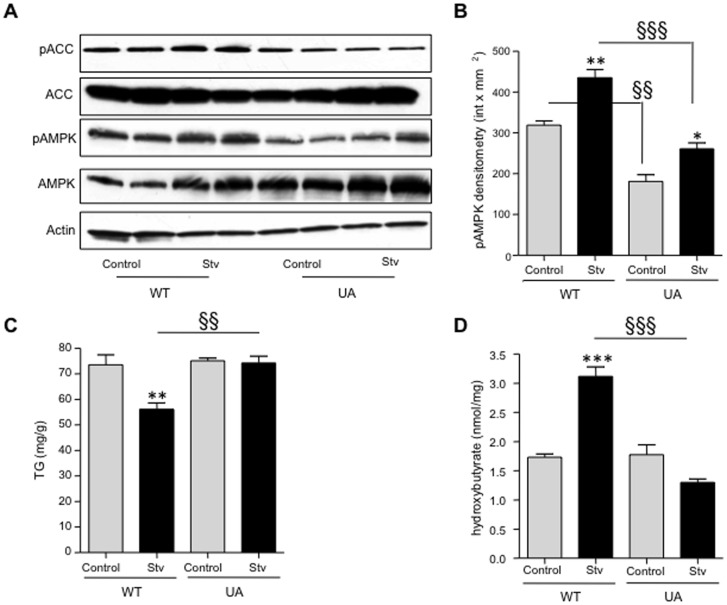
Uric acid down-regulates starvation-induced AMPK activation.HepG2 cells were exposed to 750 µmol/L uric acid for 48 hours prior 3 hour starvation (stv) and AMPK phosphorylation, intracellular TG and intracellular β-hydroxybutyrate levels were analyzed after starvation time. A–B) representative western blot and densitometry of phosphorylated AMPK in control and uric acid exposed cells undergoing starvation. *p<0.05, **p<0.01 versus control, §§ p<0.01 control vs control, §§§p<0.001 stv vs stv C) Intracellular TG levels in control and uric acid exposed cells undergoing starvation **p<0.01 versus control, §§p<0.01 stv vs stv. D) Intracellular β-hydroxybutyrate levels in control and uric acid exposed cells undergoing starvation ***p<0.001 versus control, §§§ p<0.001 stv vs stv.